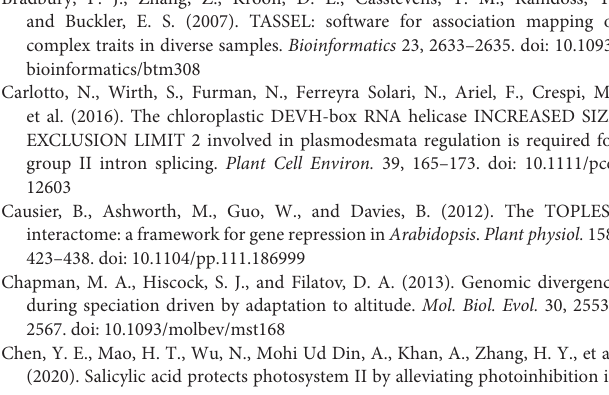
Supplementary Figure 1 | Distribution of single nucleotide polymorphisms (SNPs) in a window size of 5 Mb ( A , with all of 13,643,515 SNPs) and 20 Mb ( B , with 88,506 filtered SNPs) on 22 chromosomes of wheat. Each color represents different densities. Supplementary Figure 2 | The heatmap of kinship matrix of the 210 Elymus sibiricus genotypes. Supplementary Figure 3 | Genome-wide association study (GWAS) results of 12 phenotypic traits in E. sibiricus by GEMMA test. (A) Manhattan plots. The threshold was set as P < 9.36e-6 and 1e-3, respectively. (B) The Q-Q plots. Supplementary Figure 4 | GWAS results of 12 phenotypic traits in E. sibiricus by EMMAX test. (A) Manhattan plots. The threshold was set as P < 1.13e-6 and 1e-4, respectively. (B) The quantile-quantile (Q-Q) plots. Supplementary Figure 5 | Genome-wide association study results of 12 phenotypic traits in E. sibiricus by TASSEL test. (A) Manhattan plots. The threshold was set as P < 1.13e-6 and 1e-4, respectively. (B) The Q-Q